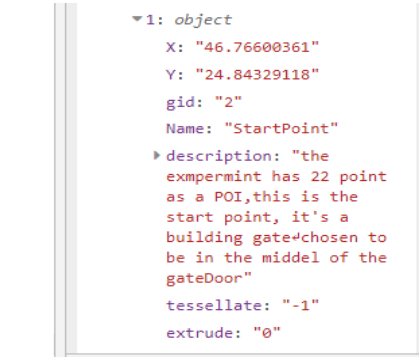
Figure 68. Payload of the data.